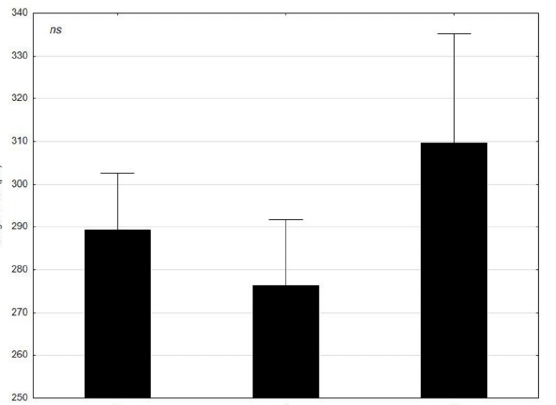
Figure 1. Mean values of C. glomerata feature (length of cells) at different times (1–30 April 2021; 2–4 June 2021; 3–17 July 2021) presented using the Tukey multiple comparisons test. The bars indicate mean values. Error bars represent standard error. A statistically significant result for p ≤ 0.05 was marked.